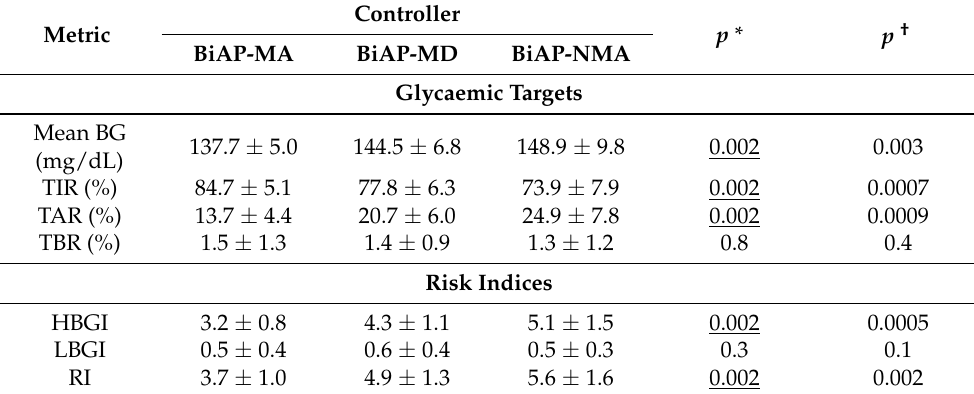
Table 2. A comparison of the performance in terms of glycaemic metrics and risk indices between different configurations of the BiAP: meal announcement (BiAP-MA), meal detection (BiAP-MD), and without either detection or announcement (BiAP-NMA). p -values calculated with Wilcoxon signed-rank test are